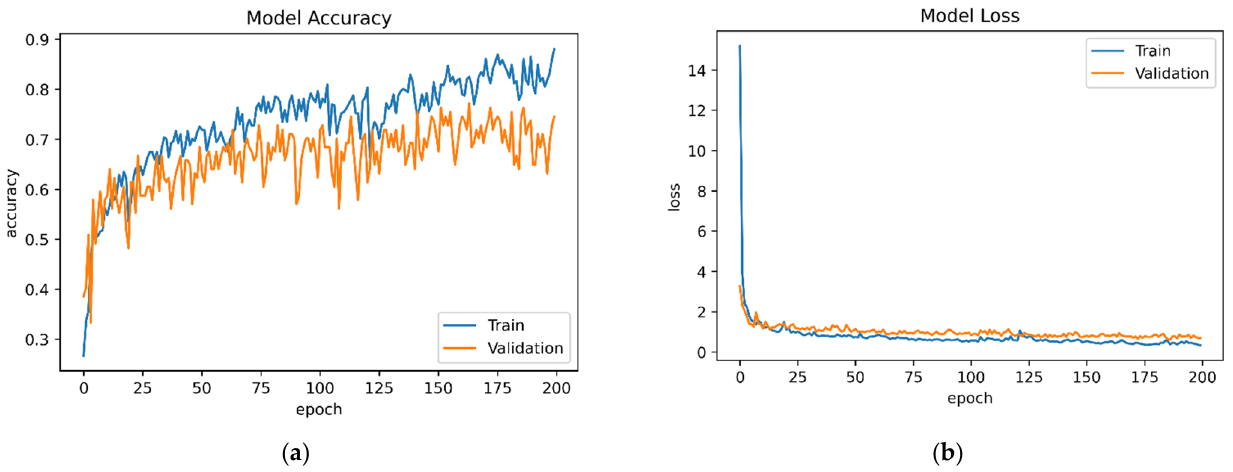
Figure 22. Deep Learning Evaluation Using DS1: ( a ) TModel1 Accuracy and ( b ) TModel1 Loss.